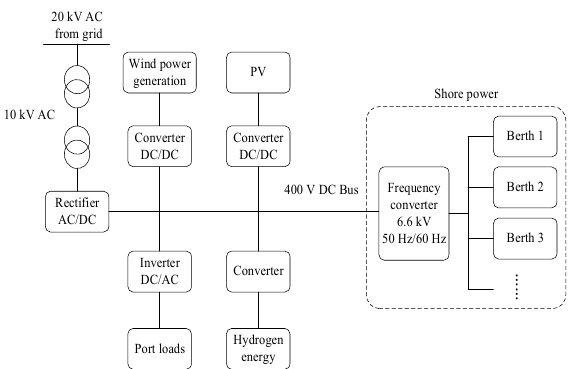
Figure 15. The hybrid micro-grid in the port.